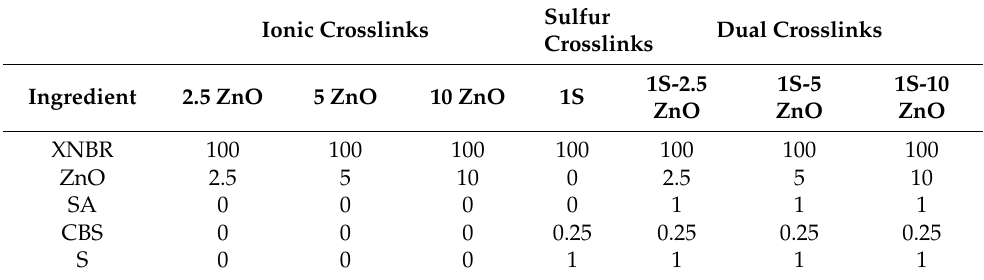
Table 1. Rubber compounds’ recipes expressed in parts per hundred parts of rubber